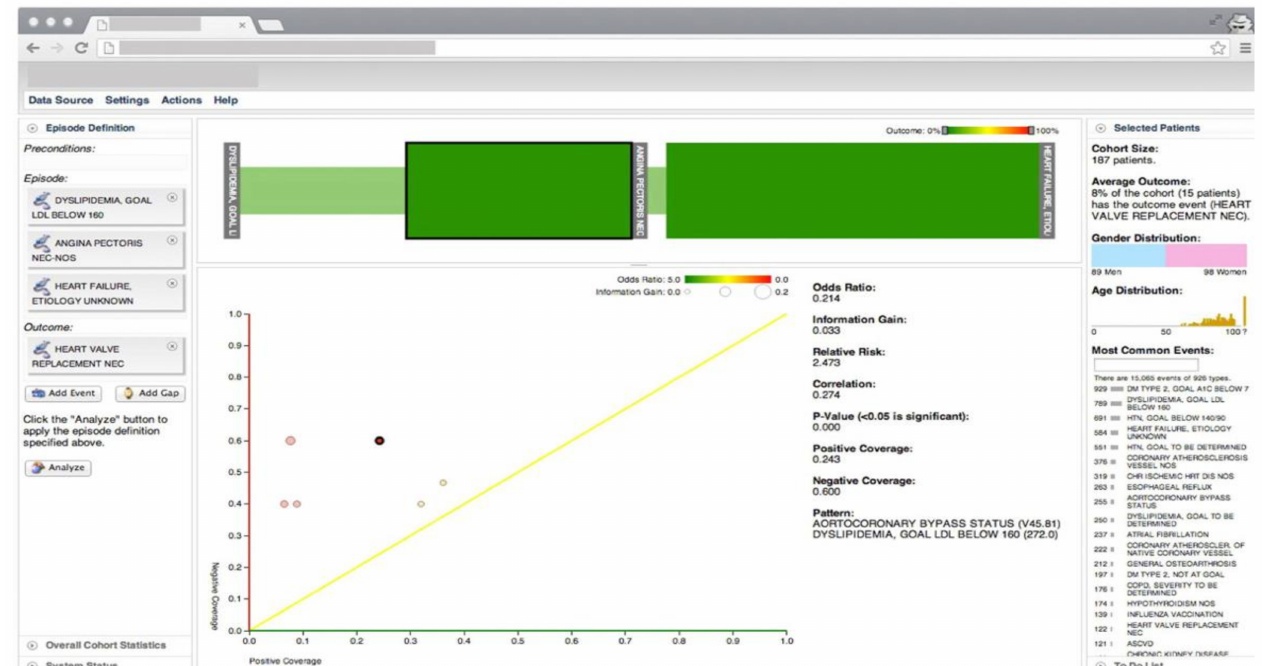
Figure 2. The screenshot of the VA system developed by Gotz et al. [26] including, the visual query panel, the milestone timeline, the cohort overview, and the pattern diagram. Source: Reprinted with permission from ref. [26], Copyright (2014), with permission from